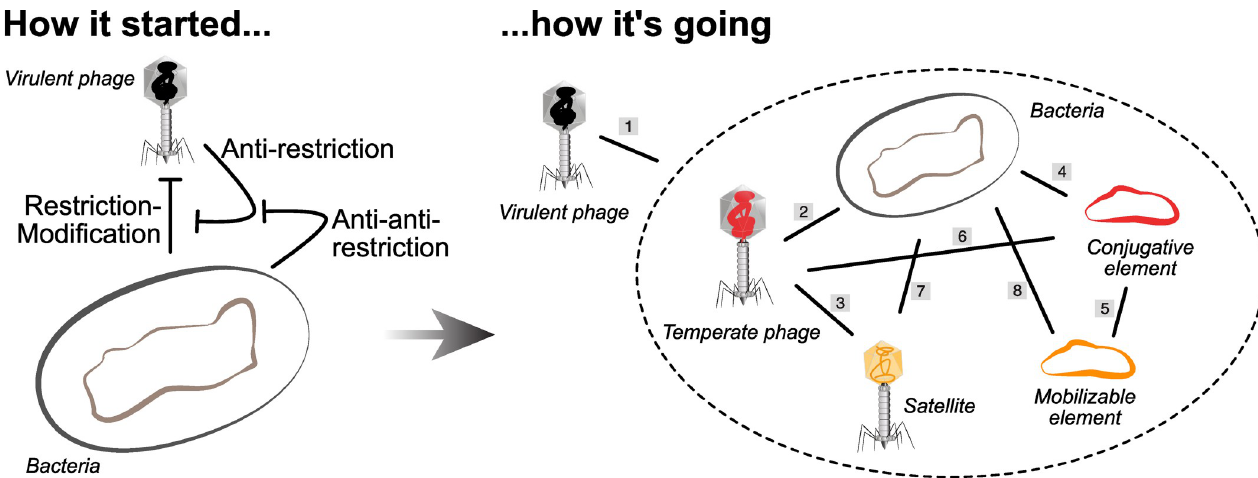
Fig 2. Defense and antidefense systems are often studied in the context of the interaction between one host and one MGE, usually a virulent phage (left). Yet, the presence of numerous MGEs in populations and their ability to encode their own defense systems renders the picture more complex (right). Virulent phages establish antagonistic interactions with the other MGEs and the cell (1). But the associations between the other MGEs and the cell can be more diverse (2 to 7). Temperate phages and conjugative plasmids exploit their cellular host (2 and 4) and can be exploited by other MGEs (3 and 5). Plasmids often encode systems that are effective barriers to phages, e.g., R–M (6). Phages are a threat to plasmids when they kill the host cell (6). Satellites may benefit the host by diminishing phage infection (7). Most of these interactions (2 to 8) can at times be beneficial to both partners, e.g., when a conjugative plasmid provides a nosocomial bacterium with antibiotic resistance. MGE, mobile genetic